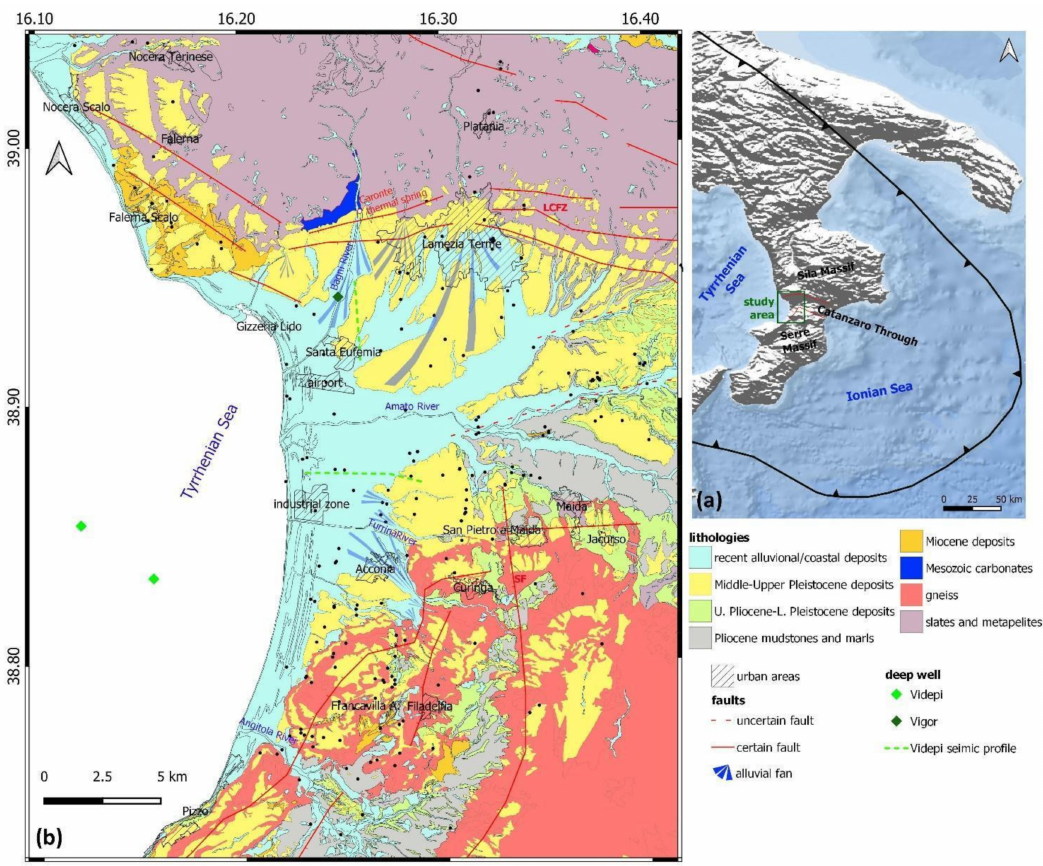
Figure 1. ( a ) Location of the study area and ( b ) simplified geological map of the SEP (LCFZ = Lamezia- Catanzaro fault zone; MF = Maida fault; SE = Serre